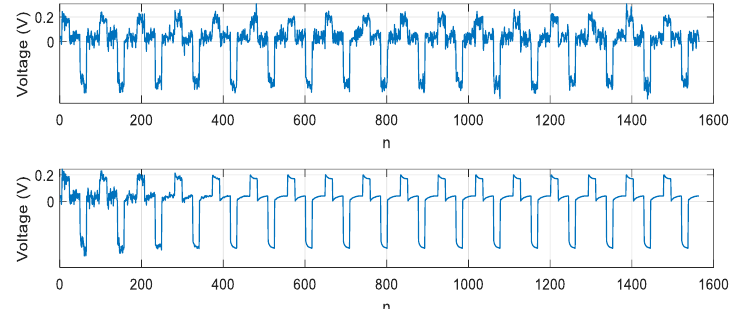
Figure 8. Dependence of extracted signal on discrete time 𝑛 = 𝑡 Δ𝑡⁄ , Δ𝑡 = 1𝜇𝑠, implying an extraction based on kurtosis.